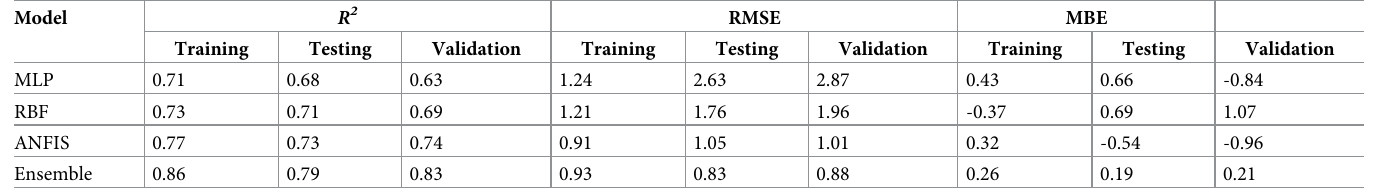
R 2 : coefficient of determination; MBE: Mean Bias Error; RMSE: Root Mean Square Error; MLP: Multi-Layer Perceptron; ANFIS: Adaptive Neuro-Fuzzy Inference System; RBF: Radial Basis